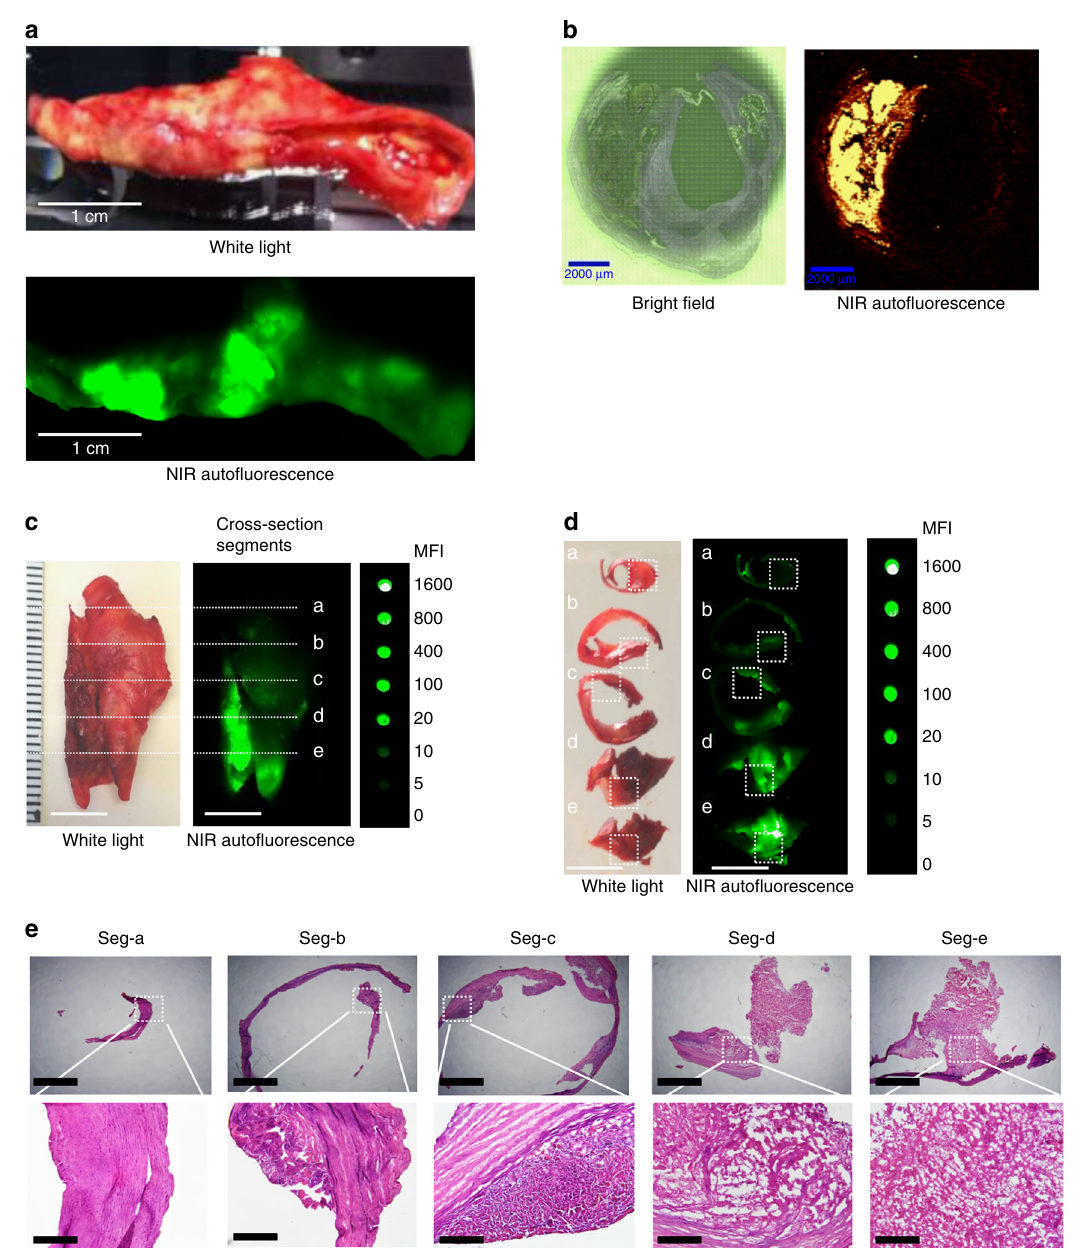
Fig. 1 NIRAF imaging of human CEA samples and representative histology in fi ve cross section segments. a Macroscopic sample of a fresh human CEA specimen under white light ( upper photo ) and fl uorescence imaging using the Odyssey Infrared Imaging System ( lower image ) showing localized areas of NIRAF ( n = 31). b Paraf fi n section of human CEA specimen (5 µ m sections): Bright fi eld ( left ) and areas of NIRAF on the WITek Raman 300R system at 785 nm excitation ( right , n = 5). c Fresh human CEA specimen under white light ( left ) and its NIRAF image using Odyssey Infrared Imaging System ( middle ) shown in comparison with a serial dilution of IRDye800CW (Em = 794 nm) ( right ). The same sample was sectioned into fi ve segments (seg-a – seg-e) along the dash lines labeled “ a ”–“ e ” as shown in c . Scale bars indicate 1 cm ( n = 8). d These fi ve plaque segments (seg-a – seg-e) under white light ( left ) and their corresponding NIRAF images using Odyssey Infrared Imaging System ( middle ) were again shown in comparison with the IRDye800CW ( right ). Seg-a has MFI of 2, seg-b = 10, seg-c = 20, seg-d = 200, and seg-e = 1000, respectively. Scale bars indicate 1 cm ( n = 8). e Histology of these fi ve plaque segments with increasingly advanced pathology stained with hematoxylin and eosin. Seg-a: intimal thickening only. Seg-b: some lipid accumulation. Seg-c: atheroma with multiple foam cells. Seg-d and seg-e: fi broatheroma with intraplaque hemorrhage. Scale bars indicate 500 µ m in the upper row and 100 µ m in the lower row ( n = 8). MFI = mean fl uorescence intensity. Square dash box indicates the magni fi cation position and reference points in the original NIRAF and under white light images (Supplementary Figs. 1 and 2). Plaque segments with intraplaque control (Fig. 2c). Serial cross-sections (seg-a – seg-d, approxi- hemorrhage developed clearly detectable NIRAF properties (MFI mately 750 µ m distance between each segment) and histology ± SEM of 2.66 ± 0.28, n = 15) in contrast to histologically stable demonstrated that seg-a represents an intermediate lesion and plaques, which showed only minimal fl uorescence (MFI ± SEM of shows low NIRAF, seg-b an advanced lesion with extensive 1.32 ± 0.08, n = 15) (Fig. 2b). The healthy artery served as a intraplaque hemorrhage and high auto fl uorescence, seg-c a NATURE COMMUNICATIONS | 8: